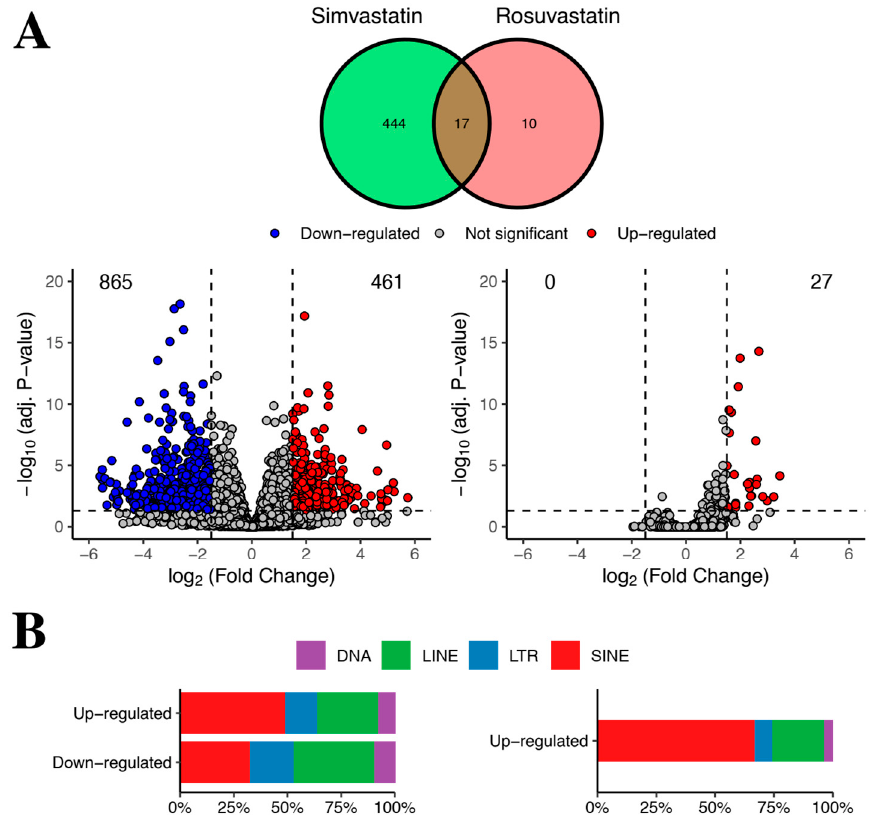
Figure 1. Differential expression of transposable elements in statin-treated human skeletal fibers. ( A ) Venn diagram and volcano plots depicting the expression profile of TEs between left, simvastatin vs. control (vehicle)-treated cells, and right, rosuvastatin vs. control (vehicle)-treated cells. Red circles correspond to up-regulated TEs (increased expression during simvastatin or rosuvastatin treatment relative to control, respectively), whereas blue circles indicate down-regulated TEs. Grey circles show TEs with no statistically significant differences in expression in either condition. The horizontal dashed lines indicate adjusted p -value 0.05, whereas the vertical dashed lines indicate − 1.5- and 1.5-fold threshold change. Numbers correspond to the TEs which were either up- (red corner) or down- (left blue) regulated for each drug. ( B ) Rectangular boxes show the TE class distribution in percentage (% of the total) among up- and down-regulated TEs for each treatment condition: simvastatin (left) and rosuvastatin (right). Colored squares indicate the color associated with each TE class: purple = DNA, green = LINE, blue = LTR and red = SINE.